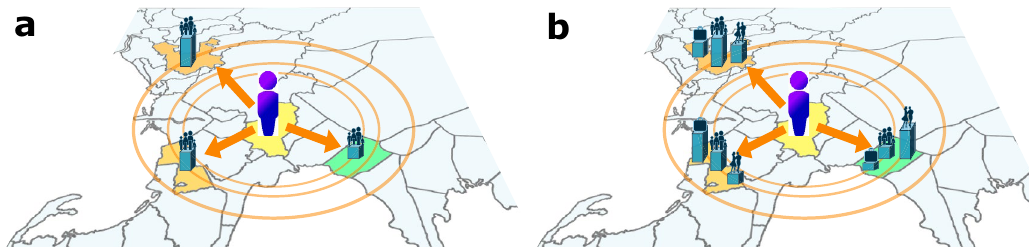
Figure 1. Radiation Model vs Generalized Radiation Model ( a ) In the original Radiation Model, a migrant is pulled more towards a locality if the locality has more economic opportunities as proxied by population, if it is closer to the origin locality, and if there are fewer neighbors with a significant pull. ( b ) In Generalized Radiation Model, the pull due to economic opportunities and the use of population as proxy are no